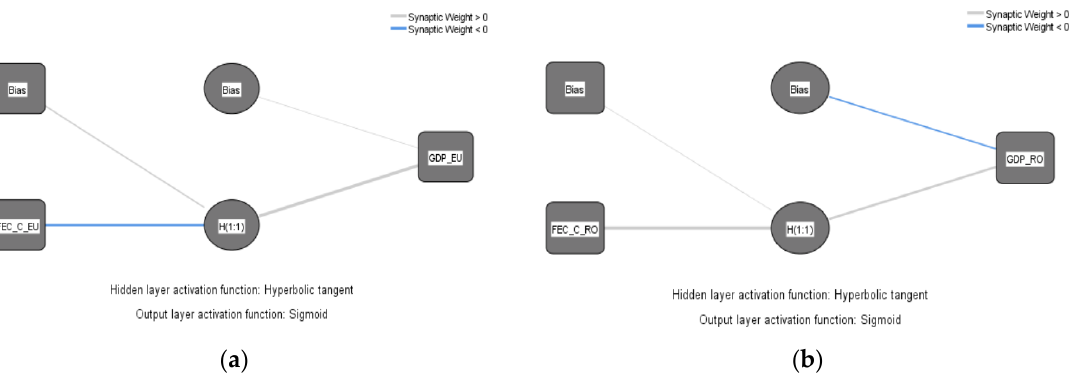
Figure 15. MLP network for identifying the influences of FEC_C on GDP at the EU level and RO levels: ( a ) EU; ( b ) RO.